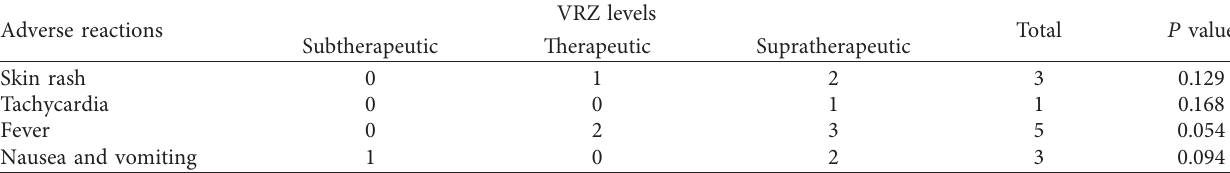
Table 2: Frequency of adverse reactions according to voriconazole plasma levels.